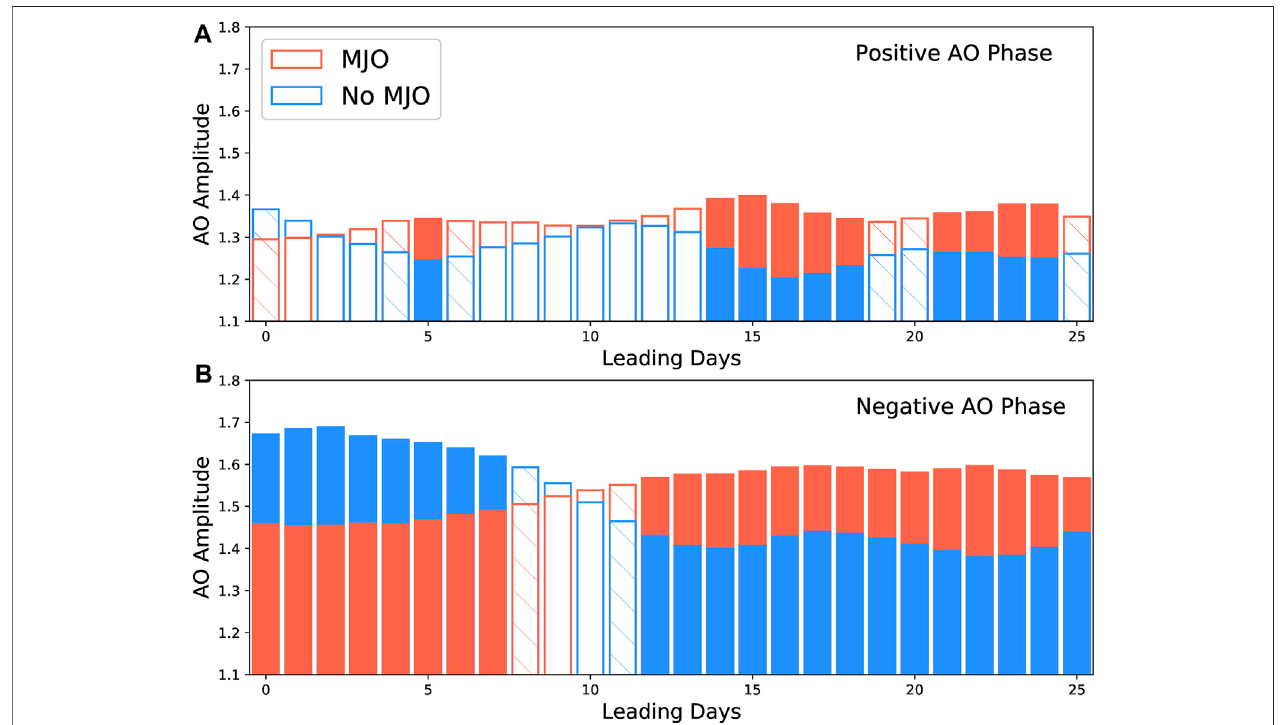
FIGURE 1 | Time-lag composites of Arctic Oscillation (AO) amplitudes when the active (orange) or inactive (blue) Madden – Julian Oscillation (MJO) event leads the AO.The x -axisrepresentsleadingdays,and y -axisisAOamplitude.Thelegendisshowninpanel A .Panels A and B areforAOamplitudewhentheAOphasesonleading day0arepositiveandnegative,respectively.Thebars fi lledwithcolor(hatch)aresigni fi cantat5%(10%)levelintermsofthedifferencesbetweentheAOamplitudeswith and without the MJO on day 0. The signi fi cant test is based on the Monte Carlo method introduced in the Signi fi cant Test